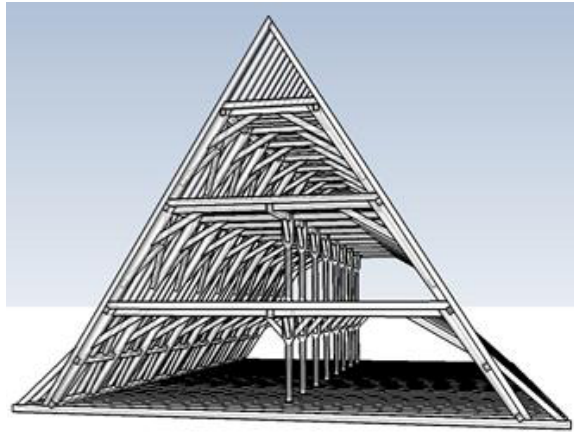
Figures 9d: Details of the 2 nd level of the framework